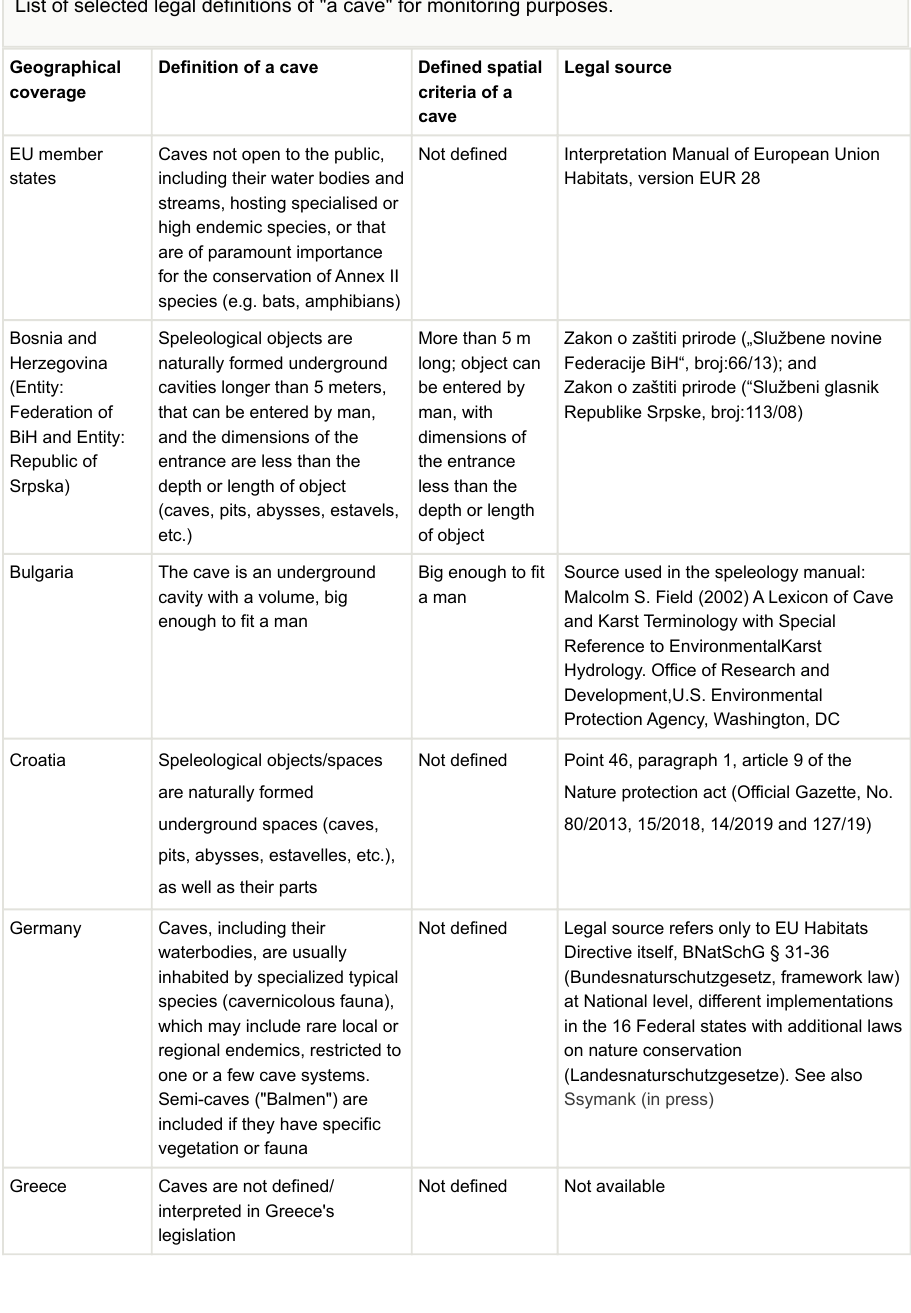
Current cave monitoring practices, their variation and recommendations